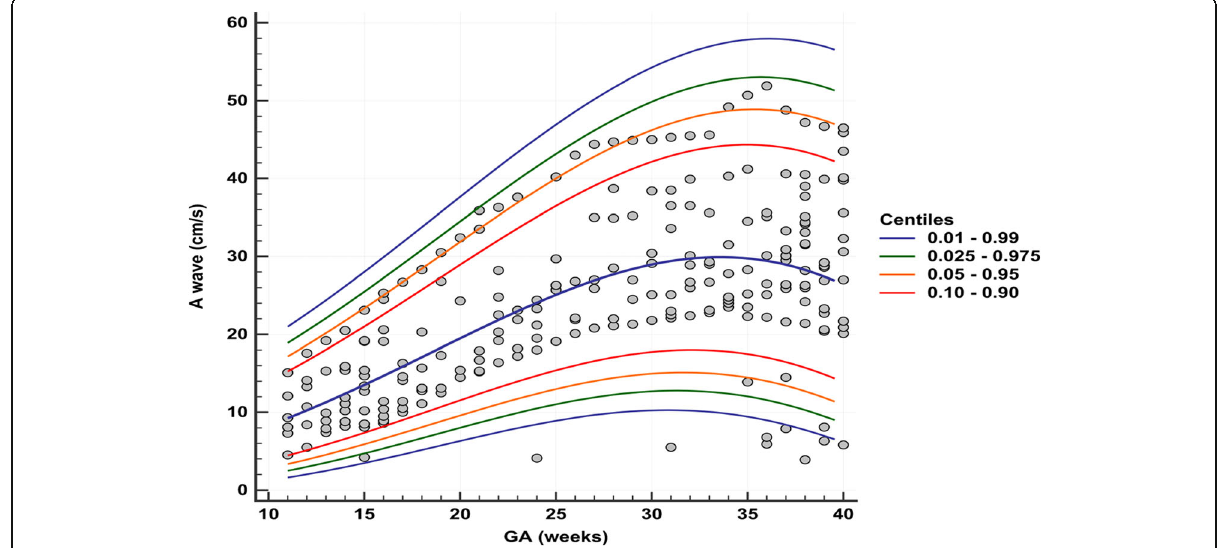
Fig. 7 Scattered diagram of gestational age individual measurement and calculated reference ranges for DV A wave velocity in normal pregnancies (690observations) with 1th – 99th percentiles (blue